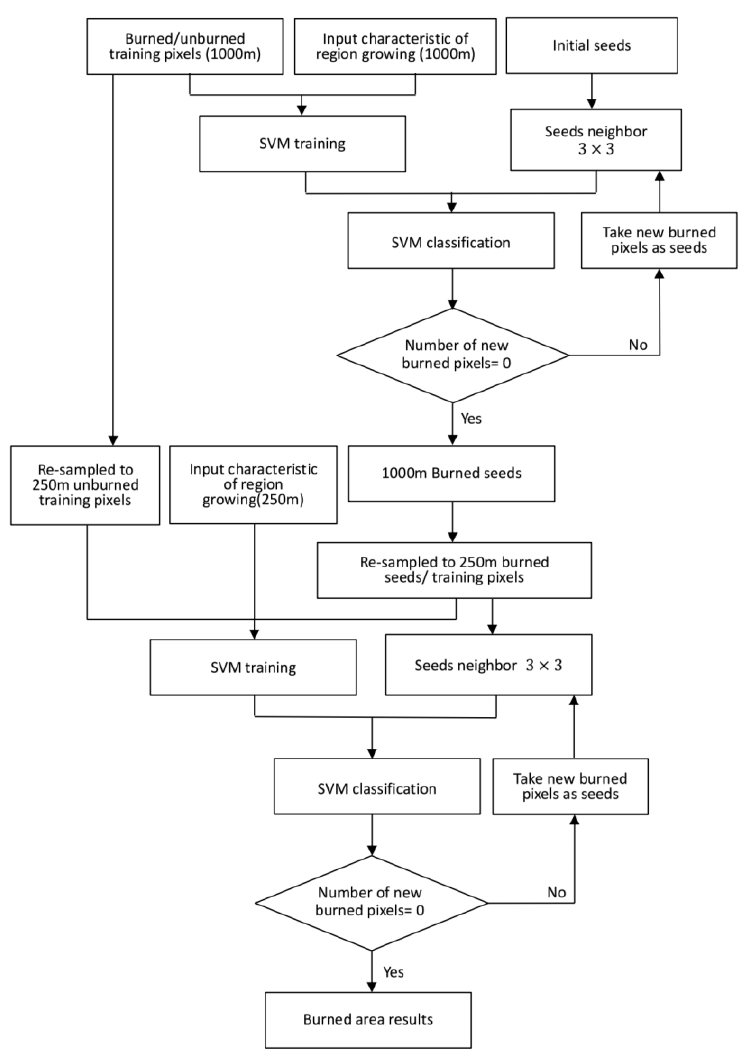
Figure 5. Flowchart for the classification of the burned pixels.